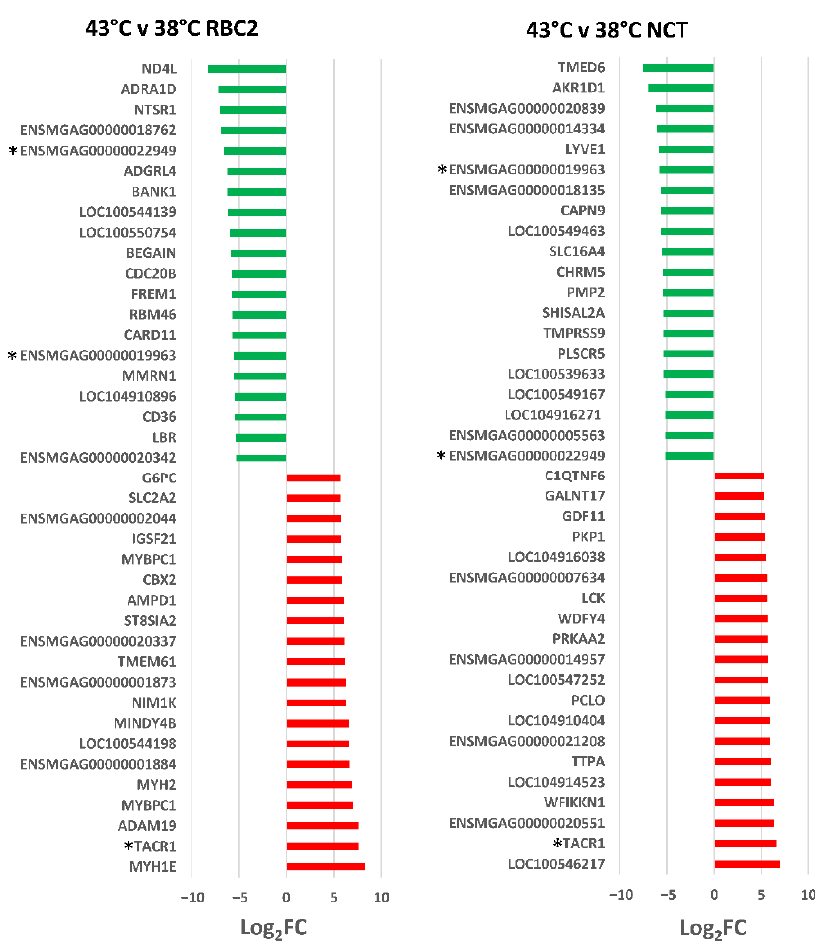
Figure 5. Directional change in the genes showing the highest expression differences in comparison between lines (RBC2 and NCT) at 43 °C and 38 °C. For each with-in temperature comparison the Log 2 FC is plotted is plotted for each DEG (FDR p value < 0.05). Genes shared between temperatures are indicated by asterisks (*). Directional expression of genes is indicated by red (up) or green (down).